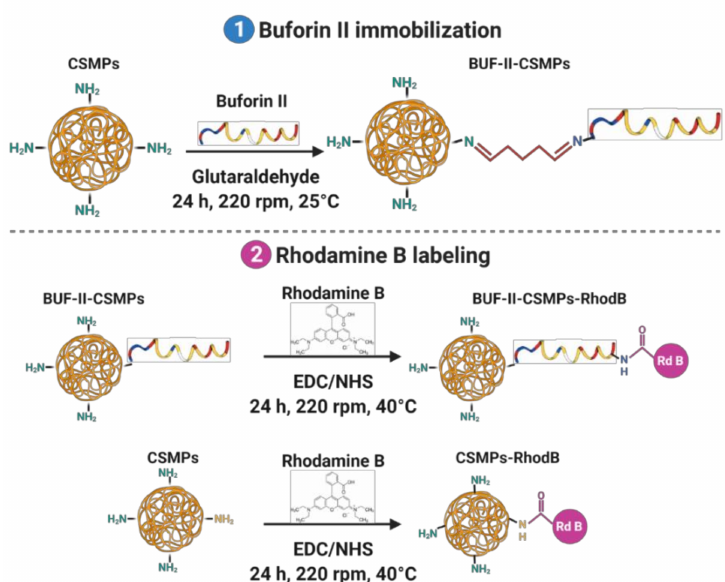
Figure 3. Schematic of the functionalization and labeling of the MPs: (1) Buforin II conjugation by forming imine bonds between its N-terminal and the pendant amine groups on the CSMPs surface mediated by glutaraldehyde as crosslinking agent. (2) Labeling with Rodamine B by conjugation to immobilized BUF-II and bare CSMPs through amide bonds formed aided by